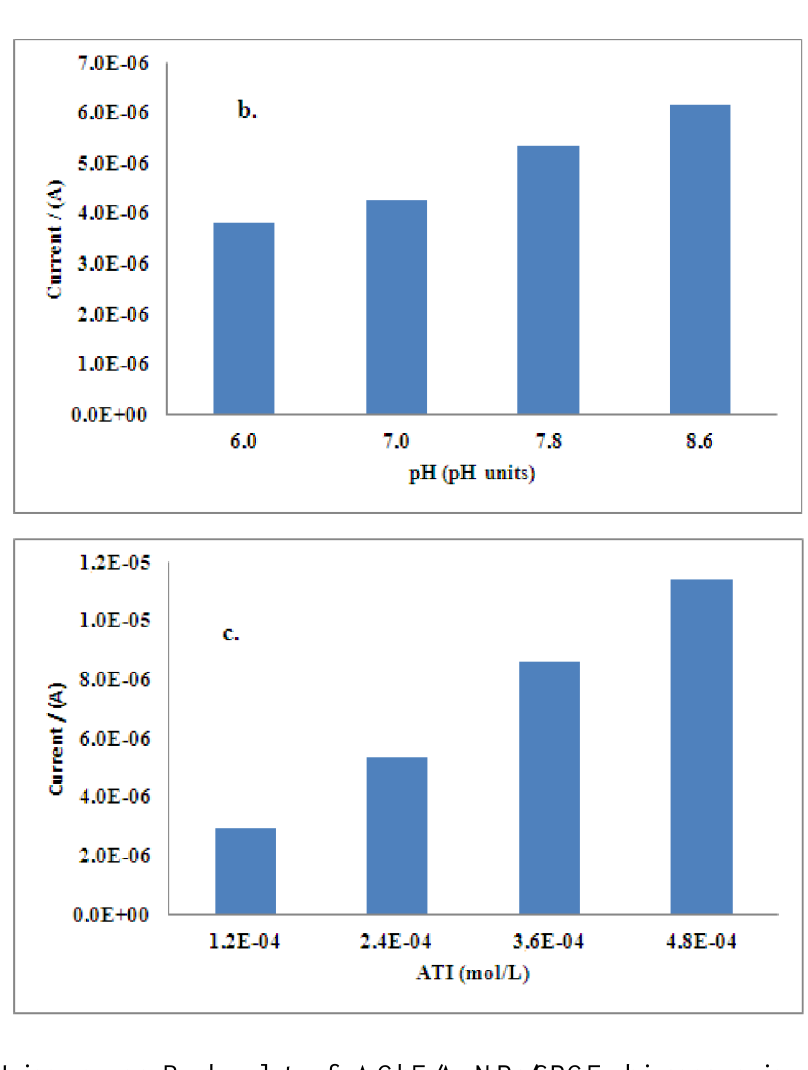
Figure 2. Lineweaver Burk plot of AChE/AuNPs/SPCE biosensor in presence of aluminum and without